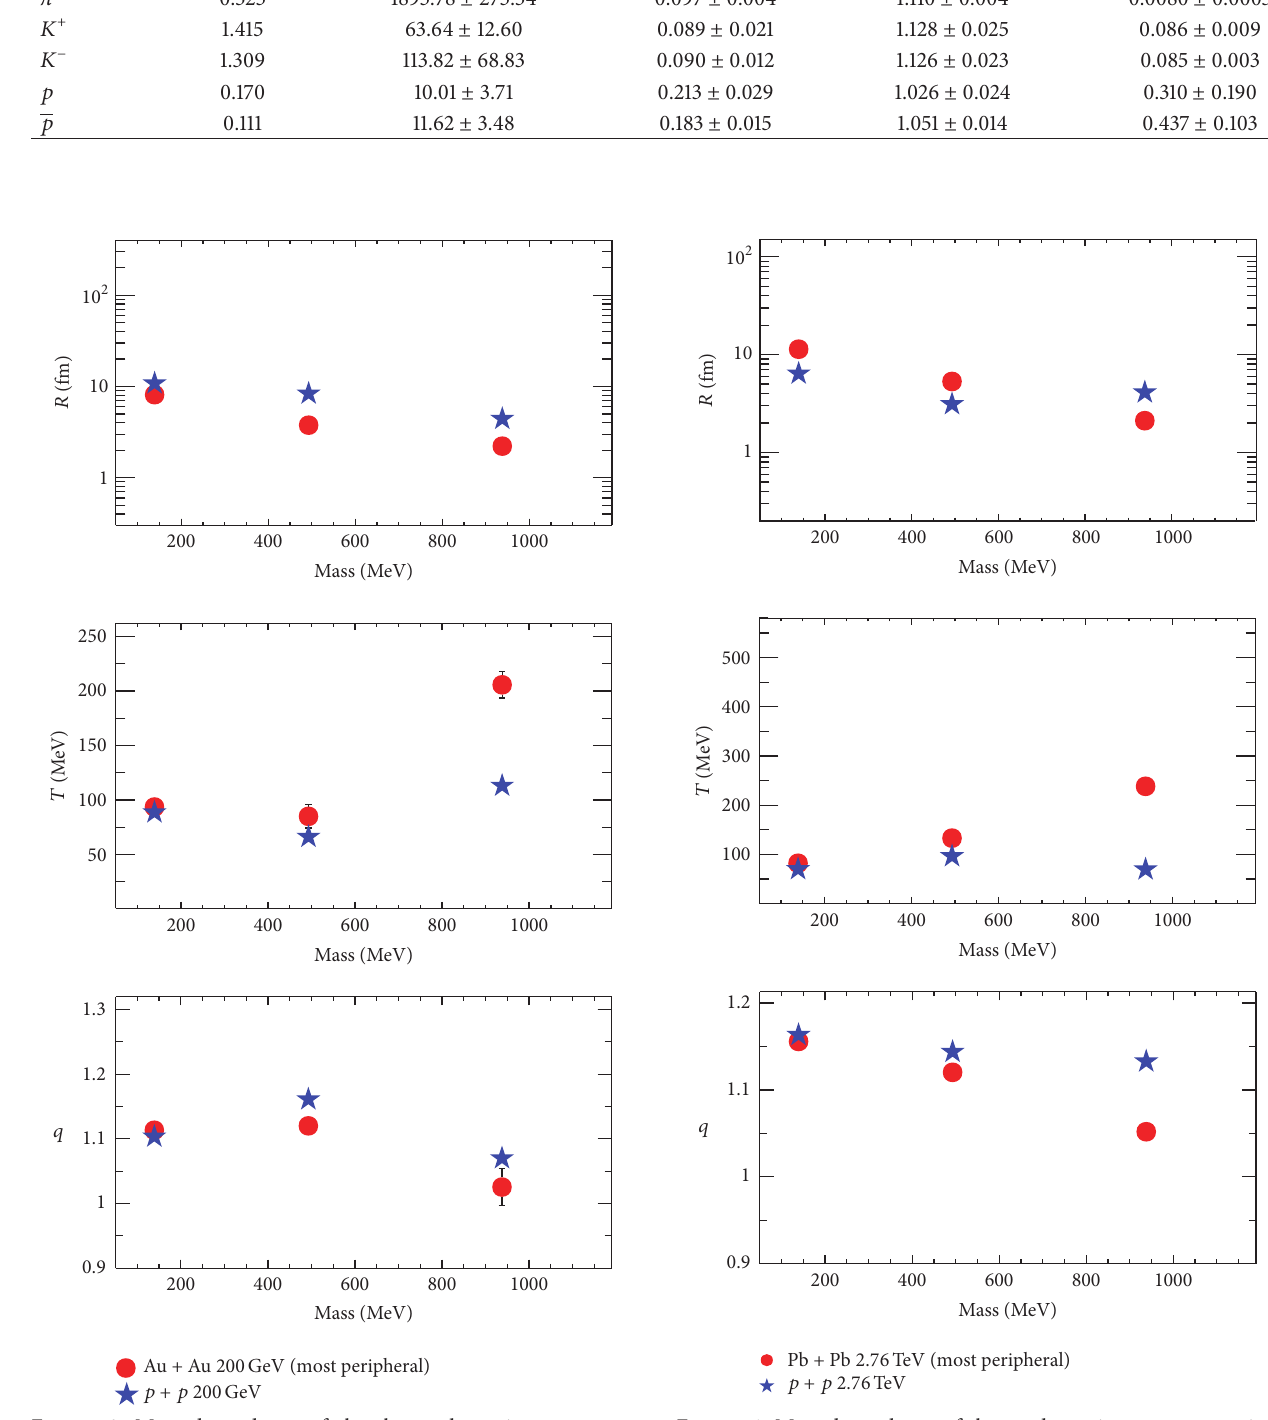
Figure 3: Mass dependence of the thermodynamic parameters using (7) for most peripheral Au + Au and 𝑝 + 𝑝 collisions at √𝑠 NN = 200 GeV.